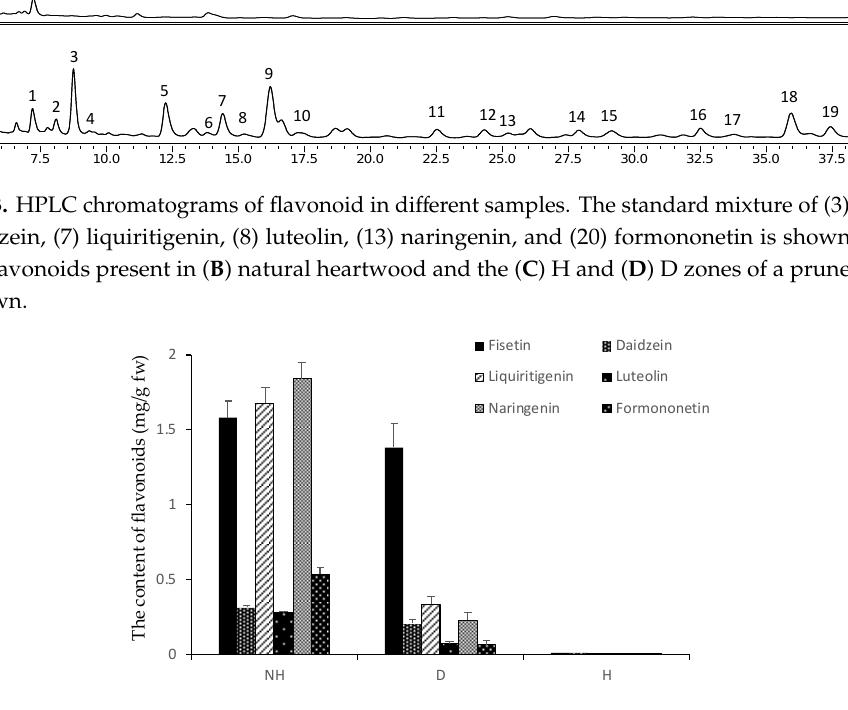
Figure 4. The contents of six flavonoids in natural HW and the D and H zones of pruned stem .